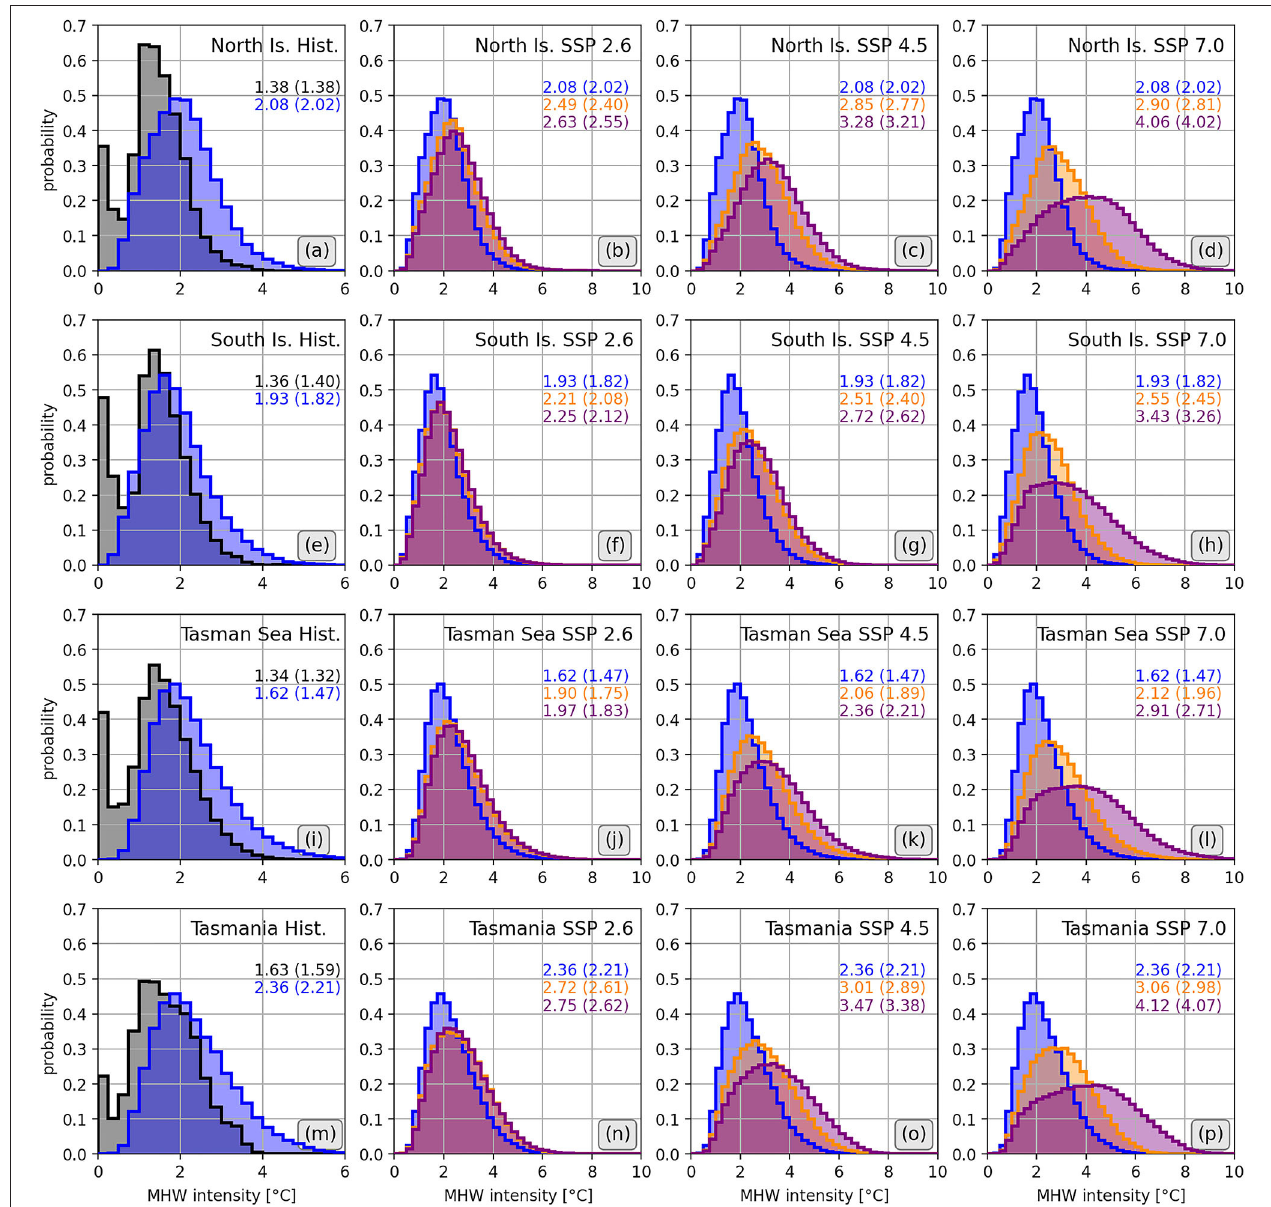
FIGURE 3 | Evolution of MHW intensity. Histograms show the probability distribution for certain regions and periods for the historical simulations and future projections. (a–d) coastal region around the North Island. (e–h) coastal region around the South Island. (i–l) over the Tasman Sea and (m–p) around Tasmania. Regions are shown in Figures 1 , 2 and Supplementary Figure S4 . NOAA OI-SST is represented by black, while NZESM is represented by blue for the historical period 1995–2014. For the future scenarios the orange and purple distribution indicates 2040–2059 and 2080–2099, respectively. The color coded numbers in each panel represent the mean (median, in parenthesis) MHW intensity for each distribution. The MHW intensity bins are 0.25 ◦ C wide and the area under curve integrates to 1. The model data represents results of a 60 year member ensemble i.e., 20 years of data from each of the three-ensemble members.